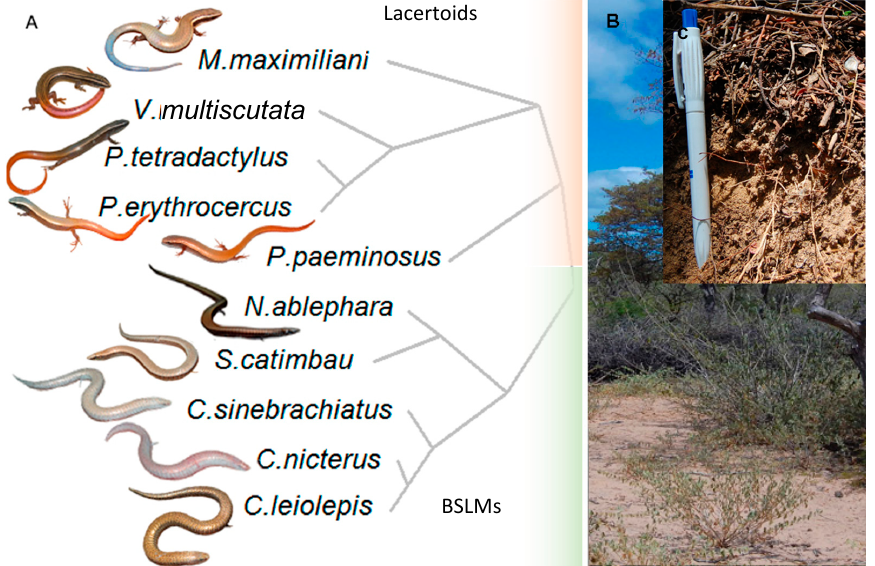
Figure 1. ( A ). Variation in body shape and phylogenetic relationships among Lacertoid and BSLM Gymnopthalmini lizards from the Caatinga (Brazil). ( B ). typical vegetation (semi-desertic shrubs). ( C ) typical soil structure inhabited by those species (leaf litter layer over sandy soil).